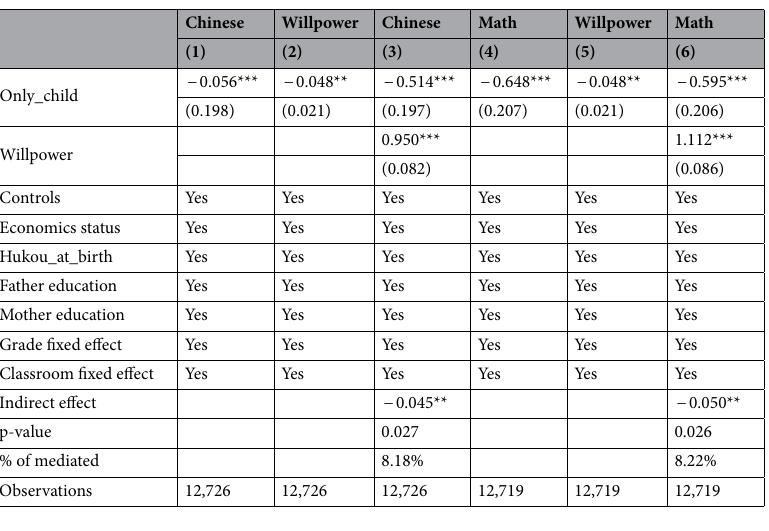
Table 10. Mechanism: Willpower. Notes: Standard errors in parentheses, adjusted for within-classroom clustering. * p < 0.10. ** p < 0.05. *** p <